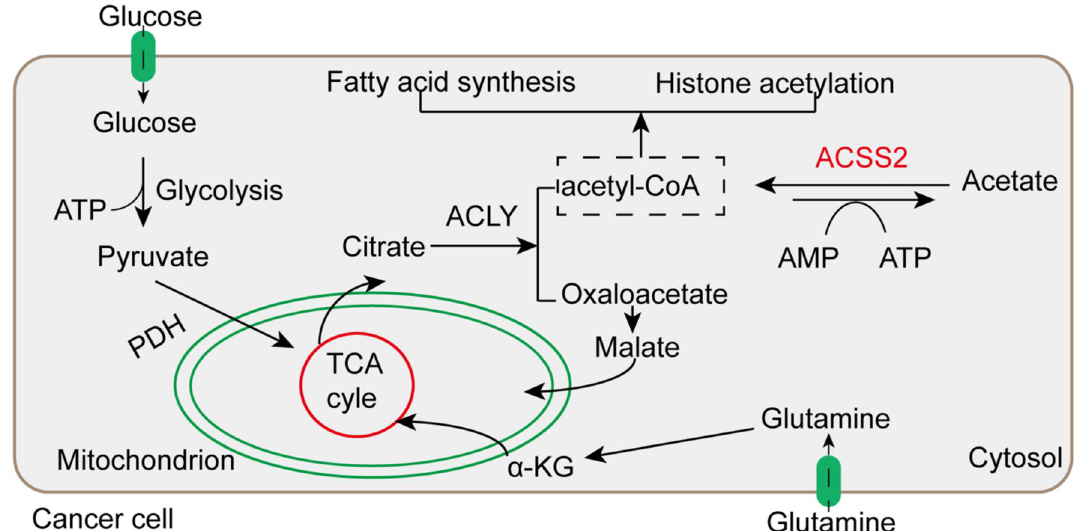
Fig. 2 Synthesis and function of acetyl-CoA. Glucose is used to produce pyruvate through glycolysis, and the generated pyruvate is con- verted into acetyl-CoA in mitochondria and enters the tricarboxylic acid cycle. In this cycle, acetyl-CoA is converted to citrate, which is then transported to the cytoplasm and converted to acetyl-CoA and oxaloacetate. In turn, oxaloacetate is converted to malate under the regula- tion of ATP citrate lyase (ACLY), and malate is converted to oxaloacetate in mitochondria. Glutamine undergoes reductive metabolism to citrate to produce acetyl-CoA. ACSS2 catalyzes a reversible reaction between acetyl-CoA and acetate in cancer cells. Acetyl-CoA is used for lipid synthesis and histone